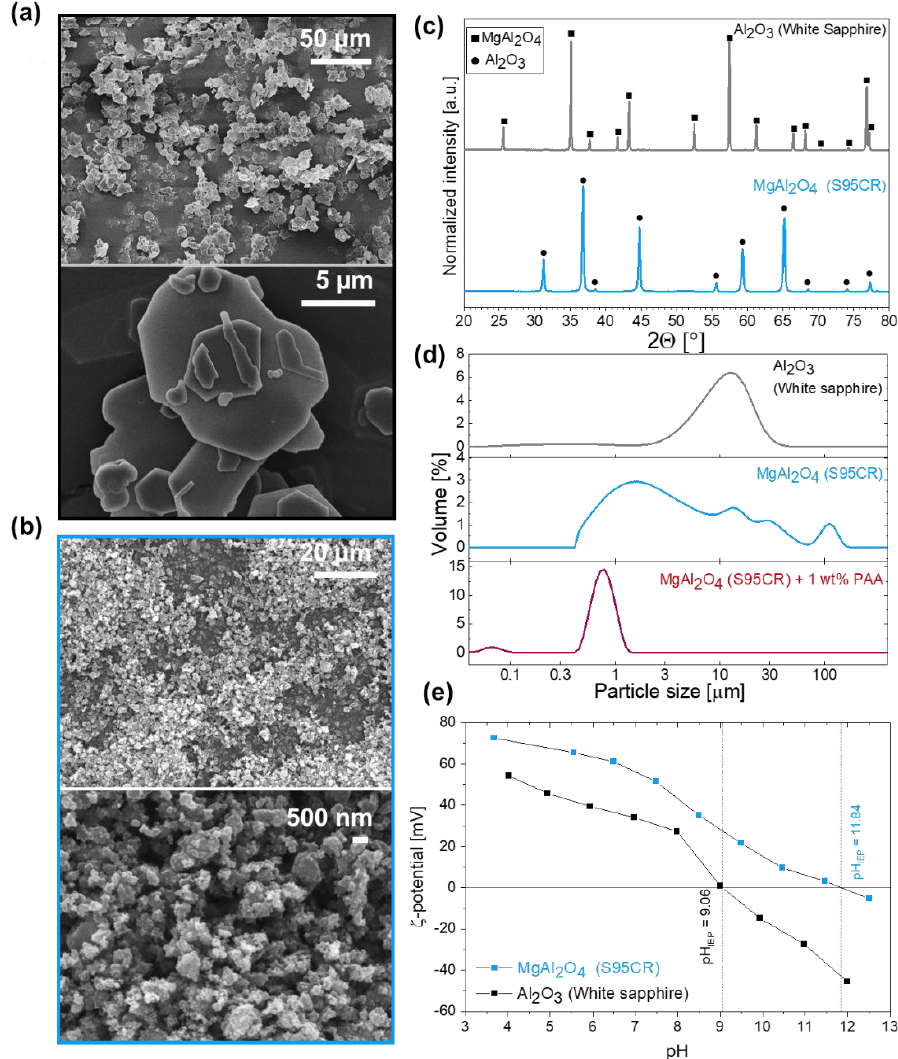
Figure 1. Characterization of the starting materials, MgAl 2 O 4 nanoparticles and Al 2 O 3 (white sapphire), as represented by blue and gray colors, respectively. Electron micrographs of ( a ) Al 2 O 3 (white sapphire, Al-Pl) and ( b ) MgAl 2 O 4 nanoparticles (Mg-NP), ( c ) X-ray diffractogram, ( d ) particle size distribution, and ( e ) zeta potential as a function of pH.